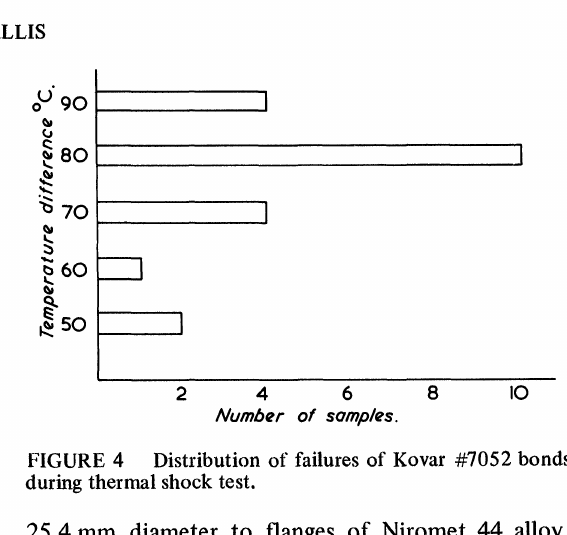
Distribution of failures of Kovar #7052 bonds during thermal shock test. 25.4 mm diameter to flanges of Niromet 44